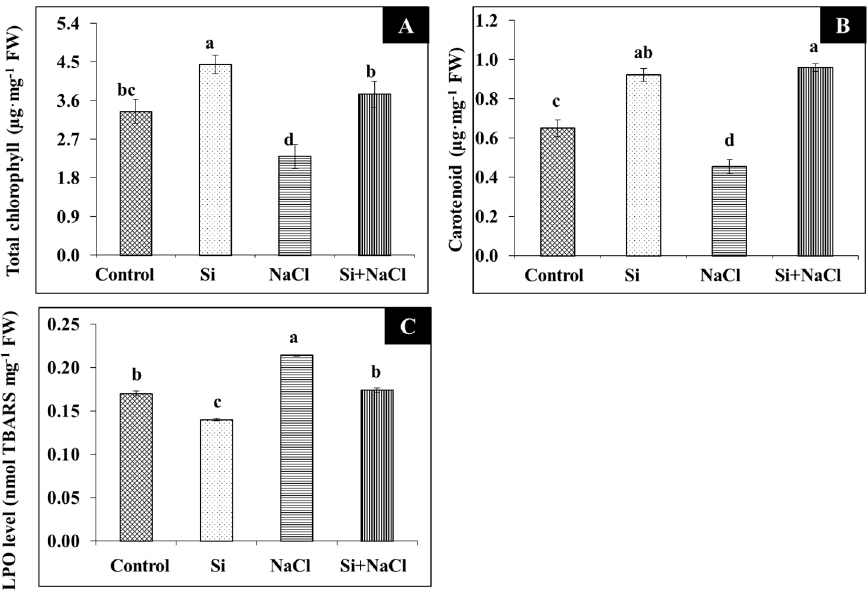
Figure 2. Photosynthetic pigments (total chlorophyll ( A ), carotenoid ( B )) and lipid peroxidation (LPO) ( C ) of Rosa hybrida ‘Rock Fire’ in response to NaCl and Si supplementation. Data are the mean ± standard deviation (SD) from three replicates. Different letters indicate that treatments are significantly different at p ≤ 0.05.